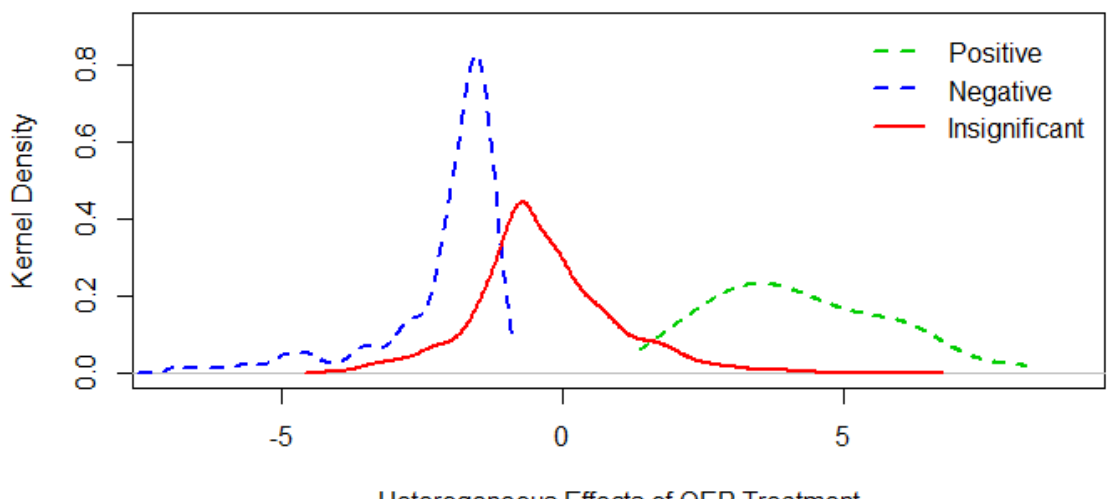
Figure 3. Distributions of heterogeneous OER effects from nonparametric Model